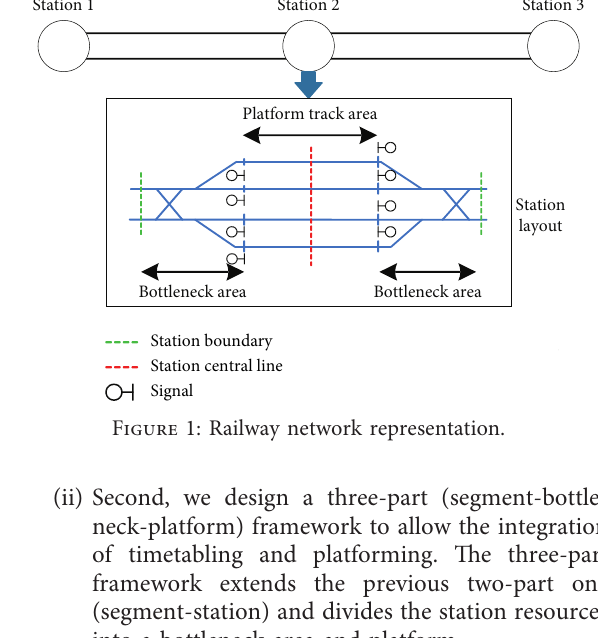
Figure 1: Railway network